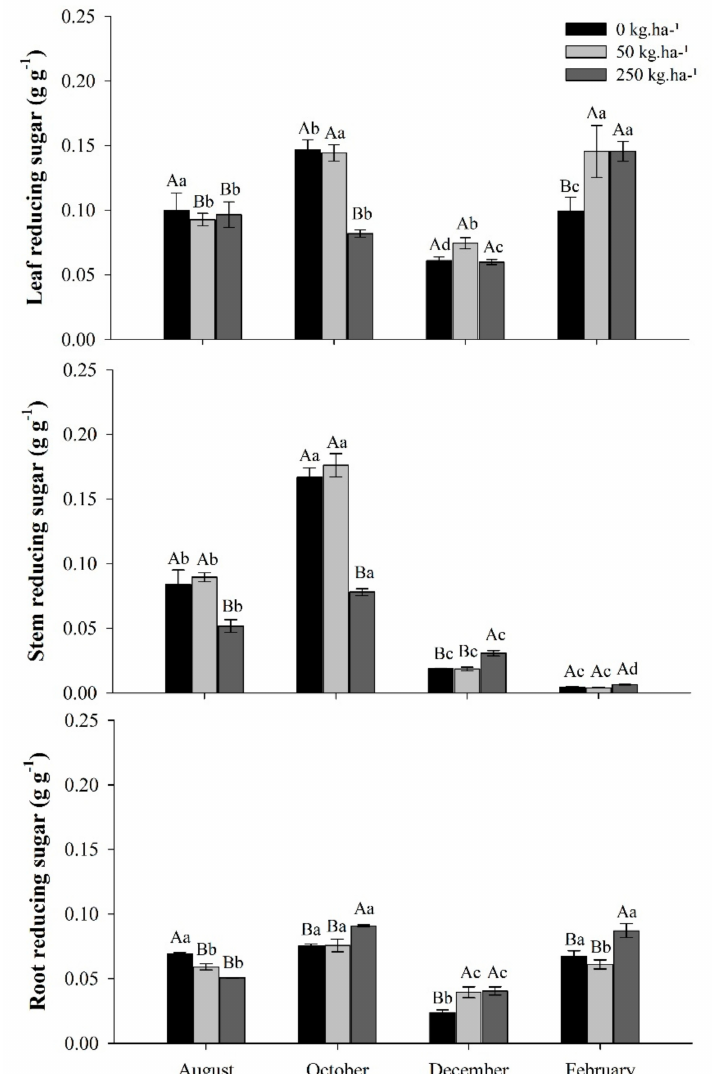
Figure 4. Reducing sugar in leaves, stems, and roots of C. guianensis plants fertilized with phosphorus at different collection periods. Means followed by distinct letters differ from each other ( p < 0.05), where uppercase letters represent the differences between treatments and lowercase letters between the evaluation